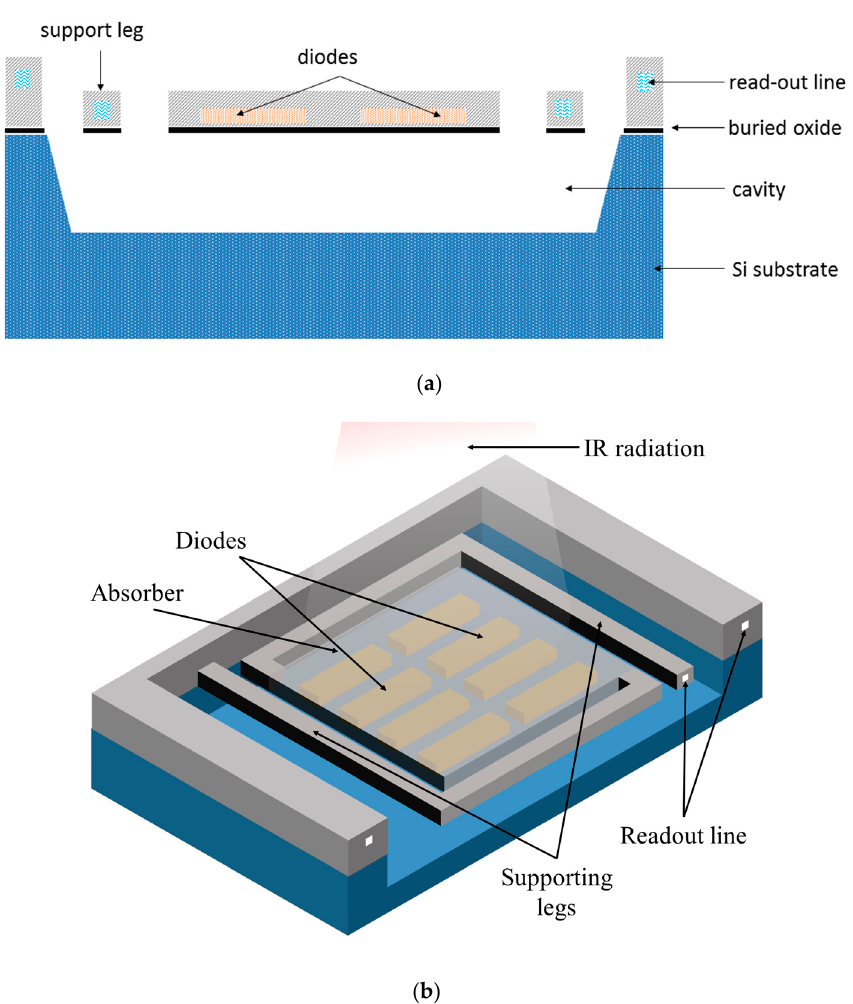
Figure 5. The pixel structure of a diode type microbolometer: ( a ) cross-sectional view and ( b ) 3D perspective view.